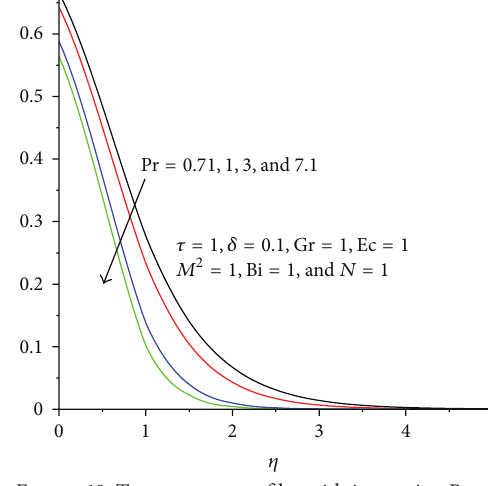
Figure 18: Temperature profiles with increasing Pr.